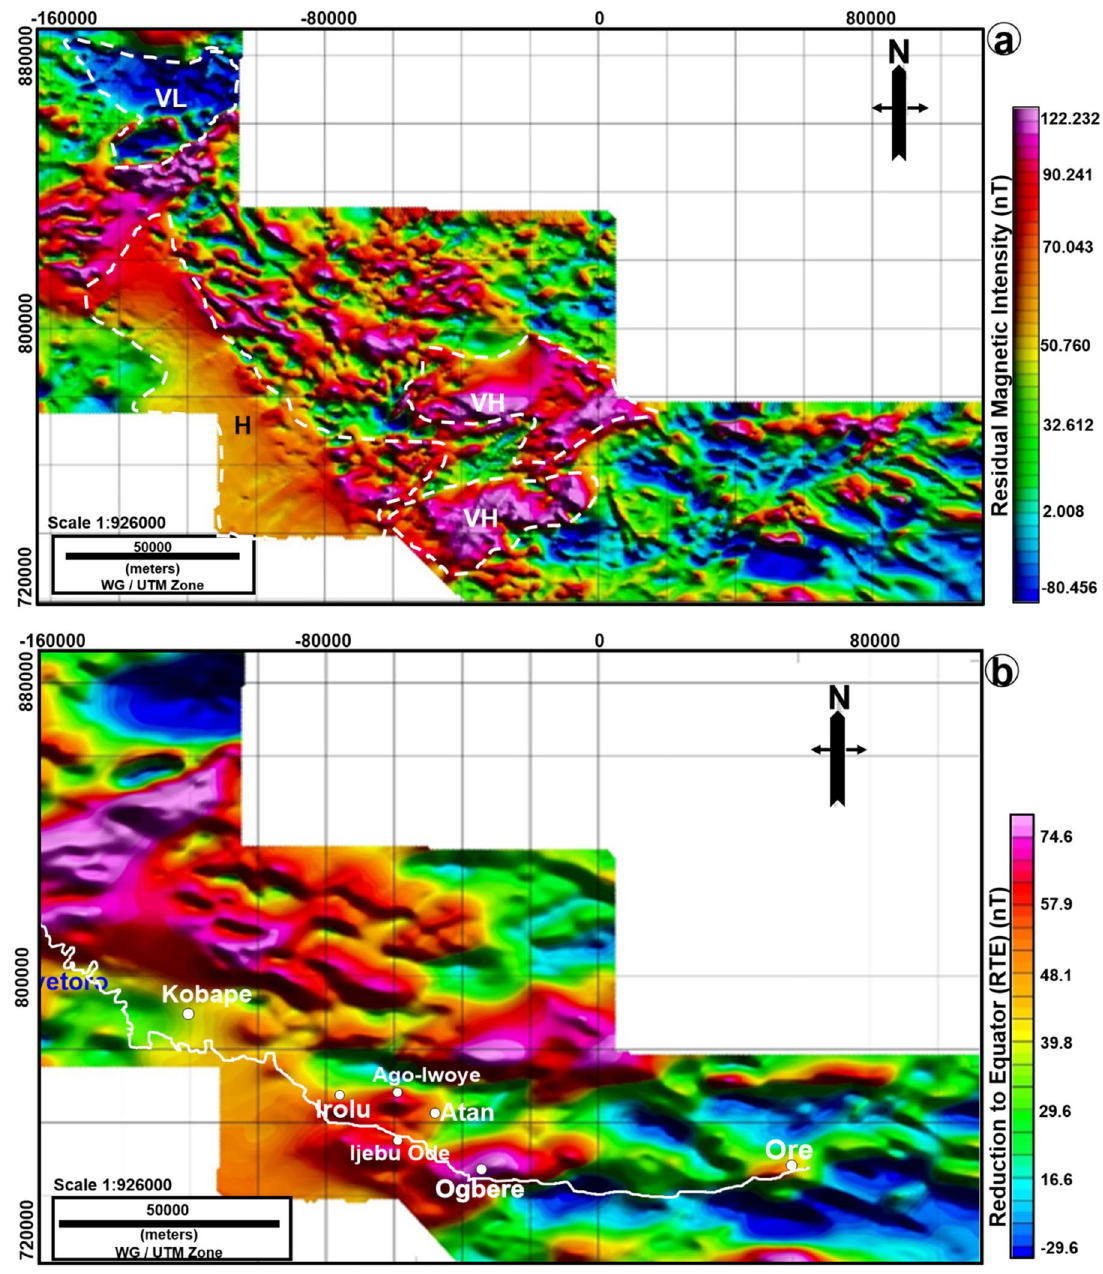
Figure 3. ( a ) Residual Magnetic Intensity (RMI) in nanoTesla (nT) grid displayed as a shaded relief map. Also shown in the map are the main localities for the VES and ERT surveys. The white line is the eastern limit of the sedimentary rocks of the Eastern Dahomey as defined by 25 . VL-very low, VH-very high and H-high anomalies. ( b ) Combined filtering using Reduction to Equator (RTE) to center the anomaly source and the Upward Continuation (UC) to enhance deep anomaly source in nT. The white line is the eastern limit of the Dahomey Basin as defined by 25 . The figure was made using Oasis Montaj software (https ://www.seequ ent.com/produ cts- solut ions/geoso ft-oasis -monta j/) and edited in CorelDRAW2017, https ://www.corel